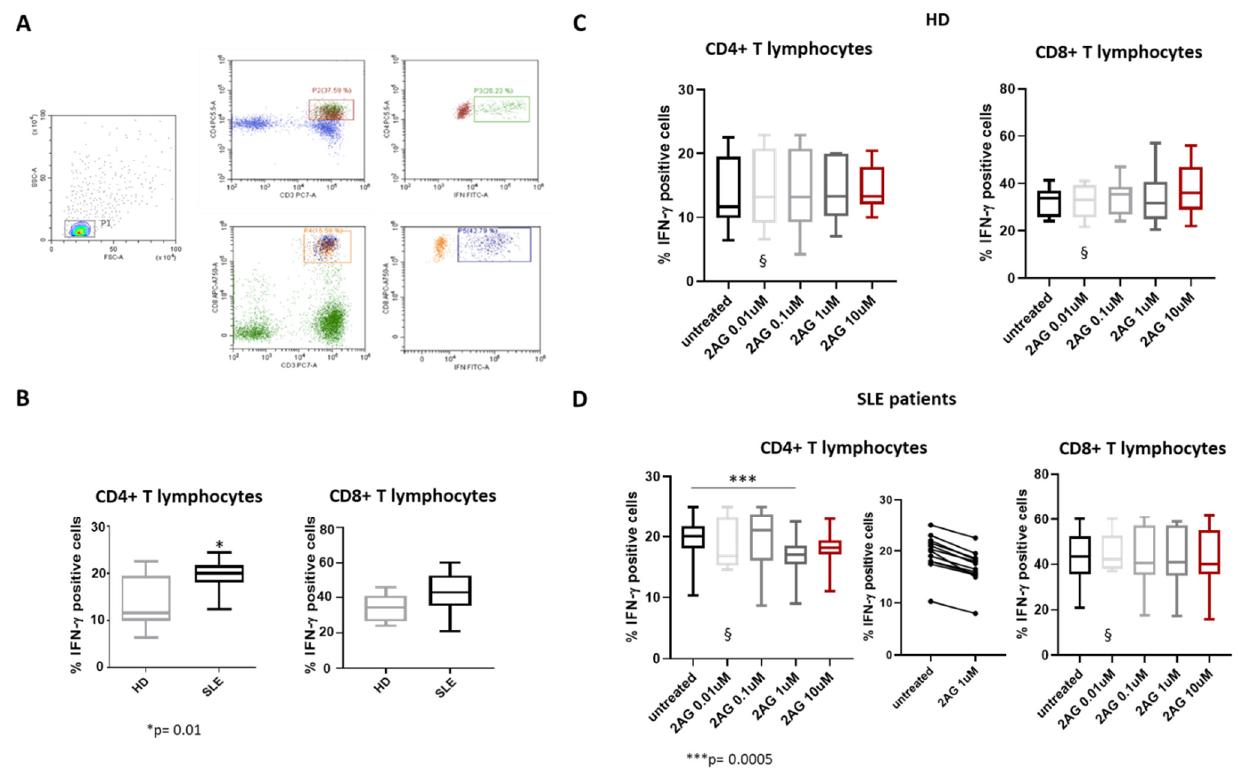
Figure 1. Effect of 2-Arachidonoylglycerol (2-AG) on Th lymphocytes expressing IFN- ɣ . ( A ) Representative dot plots of flow cytometry gating strategy used to identify IFN- ɣ -positive CD4+ T lymphocytes. ( B ) Statistical analysis of the percentage of CD4+ and CD8+ T lymphocytes expressing IFN- ɣ in healthy donors (HD) and SLE patients (n = 12 for each group). HD vs. SLE, * p = 0.01. ( C , D ) Analysis of the percentage of CD4+ and CD8+ T lymphocytes expressing IFN- ɣ after treatment with 2-AG at concentrations of 0.01, 0.1, 1 and 10 μ M in HD (C) and SLE patients (D). Data are represented as box plots displaying medians, 25th and 75th percentiles as boxes, and 10th and 90th percentiles as whiskers. § = data obtained from 5 HD and SLE patients representative of entire population. *** p = 0.0005.